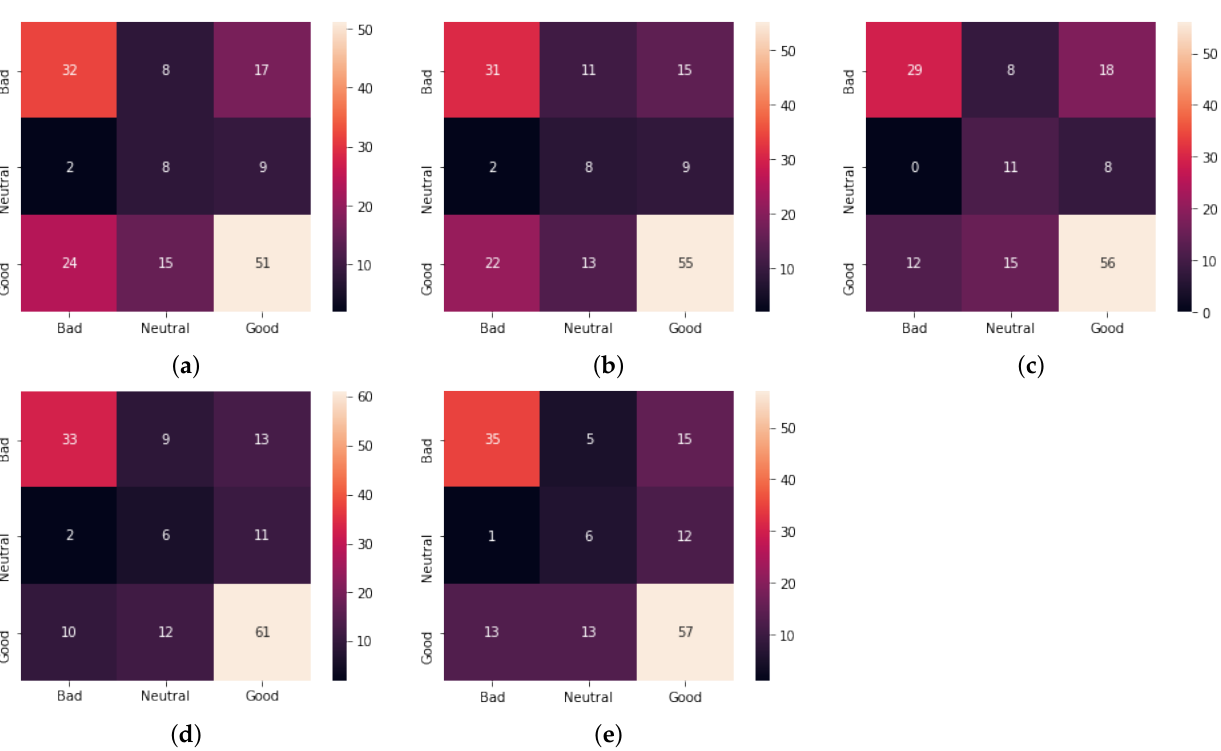
Figure 6. Confusion matrix for the five methods for the physical stress estimation in the morning (MQ). ( a ) Baseline Method 1; ( b ) Baseline Method 2; ( c ) Previous method [26]; ( d ) Proposed Method 1; ( e ) Proposed Method 2.